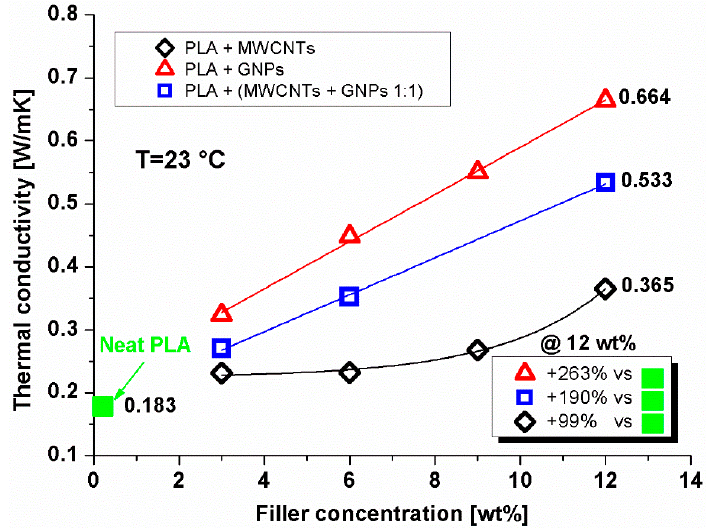
Figure 8. Thermal conductivity of carbon nanotubes (CNT) / PLA, GNP / PLA and (CNT + GNP 1:1) / PLA composites, as varying the filler contents. Markers represent experimental data, whereas lines are the interpolation curves. Table 2. Thermal conductivity (W/mK).